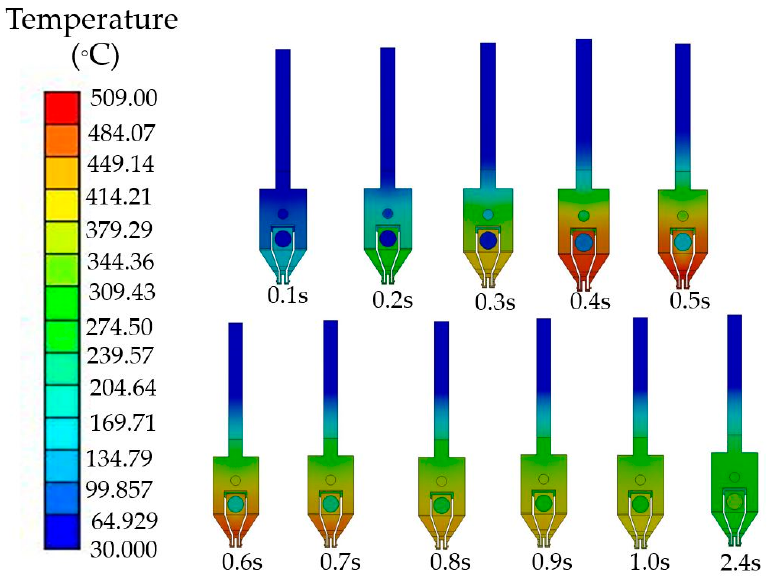
Figure 14. Heat transfer behavior and temperature of the parallel WT for 0.1 s–2.4 s.